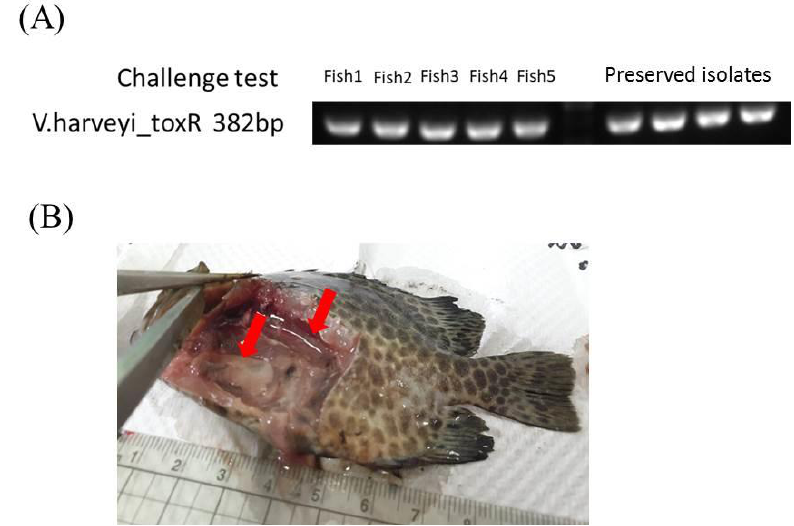
Figure 4. ( A ) Polymerase chain reaction (PCR) detection of the virulence gene toxR from Vibrio harveyi isolated from artificially infected fish (fish 1–5) and preserved isolates. ( B ) Oplegnathus punctatus exposed to V. harveyi displaying hemorrhaging in the trunk kidney and ascites in the abdomen.